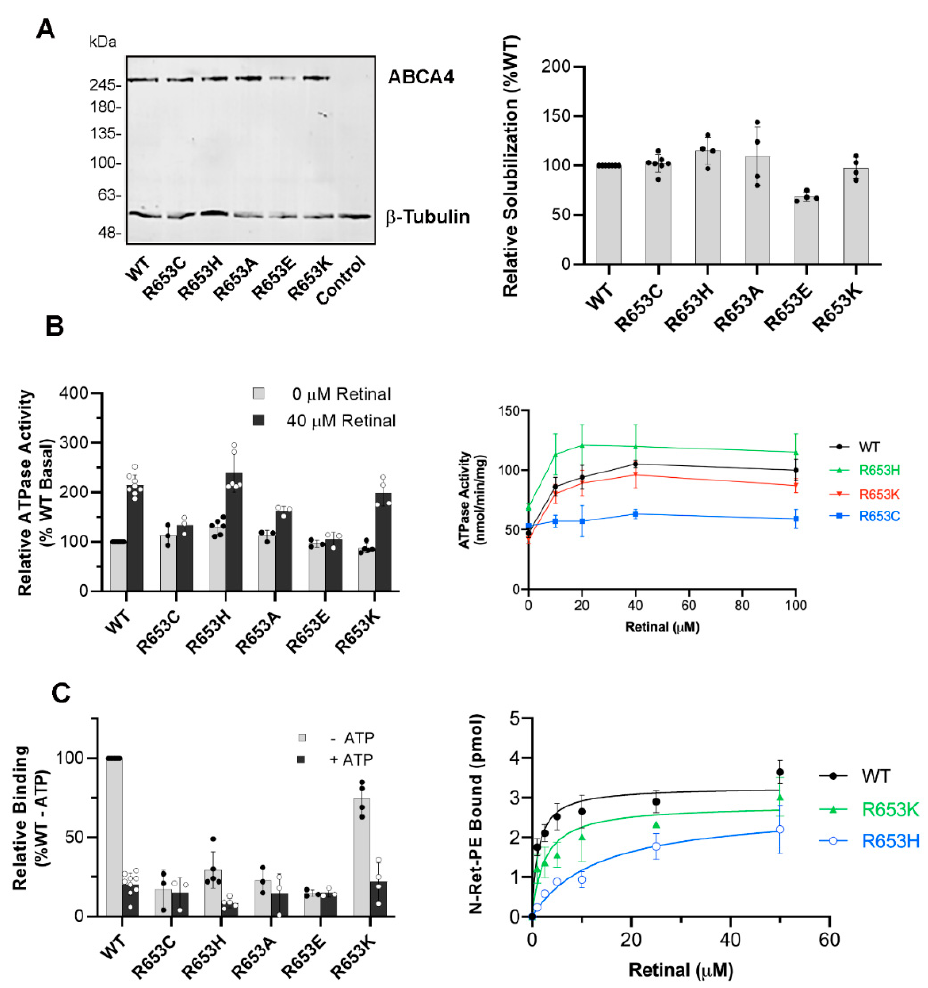
Figure 8. Biochemical analysis of R653 Variants. ( A ) (Left) Representative Western blots showing the CHAPS solubilization level of the p.R653 variants. (Right) Bar plot indicates the average relative expression of p.R653 variants ± SD ( n ≥ 2). ( B ) (Left) Relative ATPase activity of p.R653 variants in the absence (grey) or presence (black) of 40 µM all-trans retinal ( n ≥ 3). p -values with and without retinal: p.R653C ( p = 0.021); p.R653H ( p = 0.0005); p.R653A ( p = 0.0005); p.R653E ( p -value =0.426); p.R653K ( p = 0.0013). (Right) The specific AT ≥ ase activity was measured for p.R653C/H/K variants as a function of all-trans retinal concentration ( n ≥ 2). ( C ) (Left) Relative binding to N -Ret-PE in the absence (grey) or presence (black) of 1 mM ATP. p -values with and without ATP: p.R653C p value = 0.422; p.R653H 0.0087; p.R653A p = 0.289; p.R653E p = 0.833; p.R653K p = 0.0043. (Right) Best fit retinal binding curves for the variants ( n ≥ 2) with the following apparent mean Kd ±SD; WT Kd = 1.2 ± 0.2 µM; p.R653K Kd = 2.5 ± 1 µM and p.R653K Kd = 13.3 ± 2.5 µM.